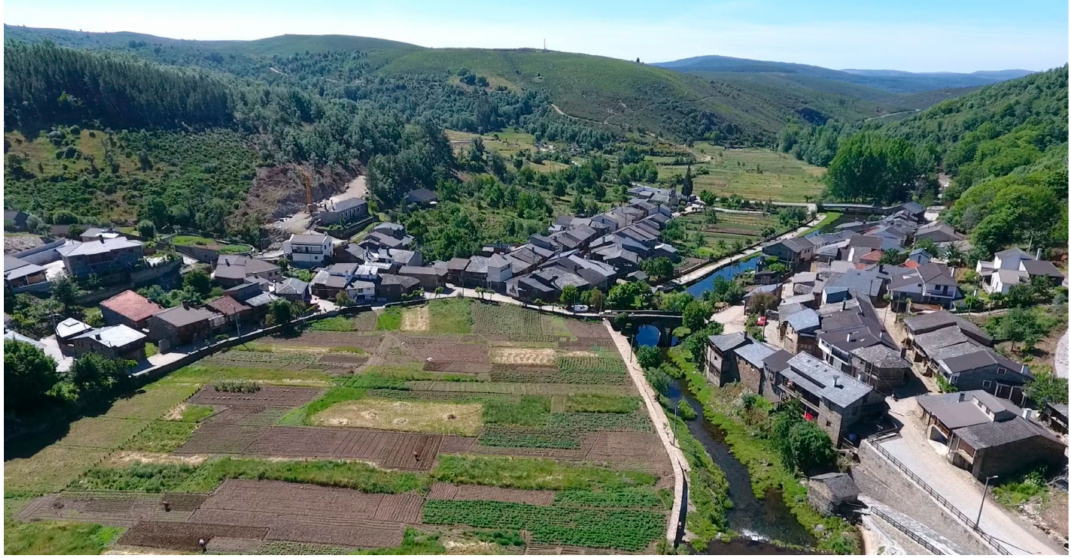
Figure 4. Urban complex of the Rio de Onor Village divided by the border delimited by the